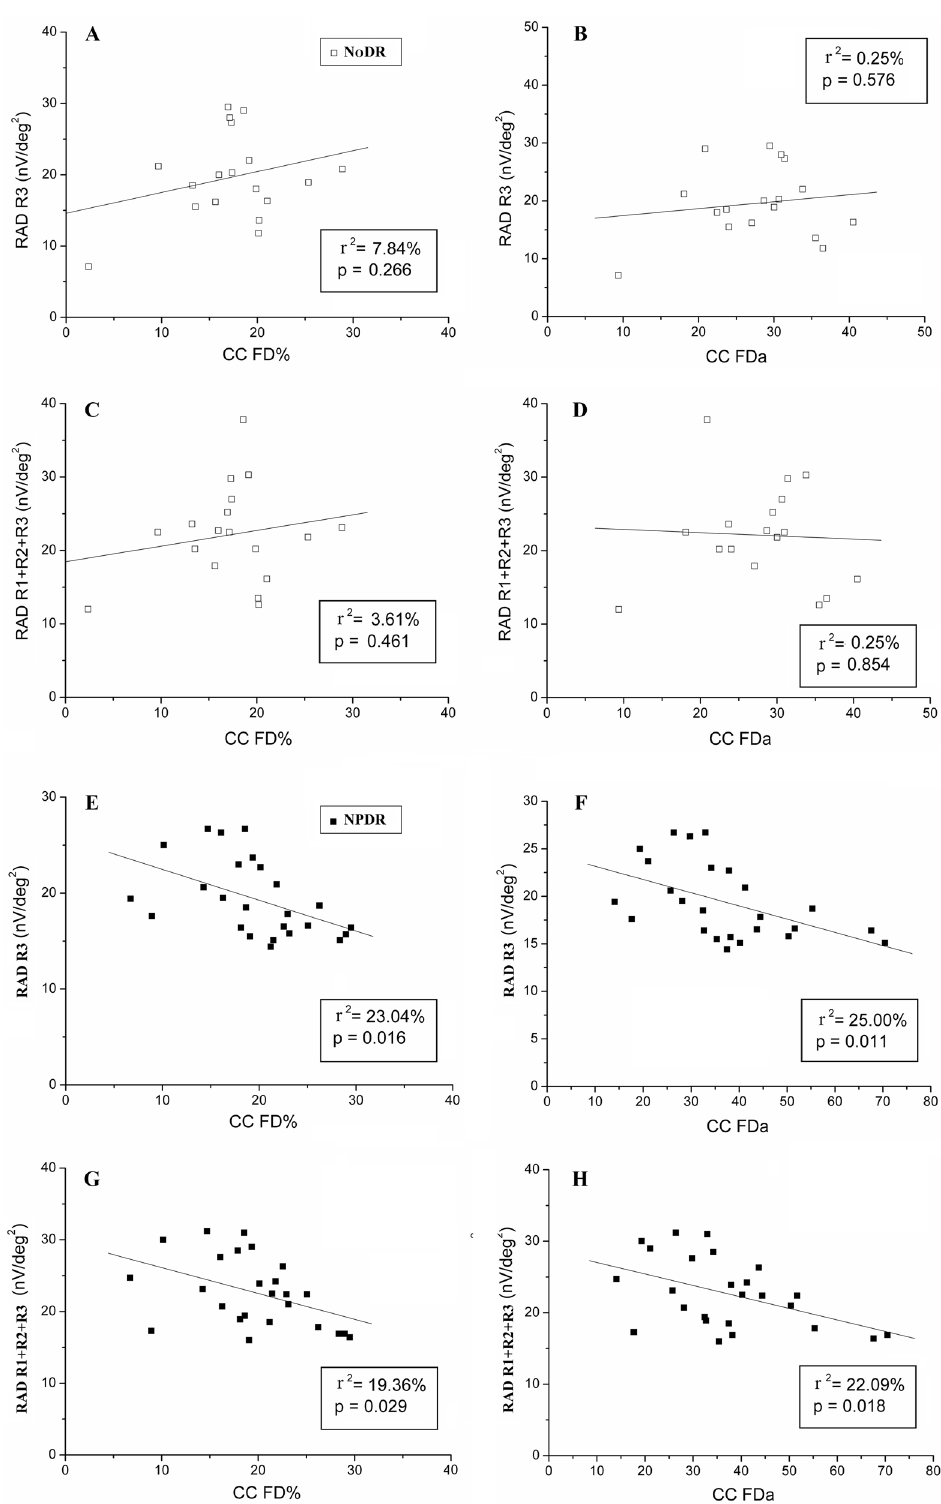
Figure 2. Scatter plots showing the linear correlations between the multifocal response amplitude density (RAD) derived from signals collected in an annular area enclosed between 5° and 10° (Ring 3, R3) or in the wider area between 0° and 10° (R1 + R2 + R3) of foveal eccentricity and the OCTA parameters of choriocapillaris flow deficit percentage (CC FD%) or choriocapillaris flow deficit area (CC FDa) in NoDR and NPDR